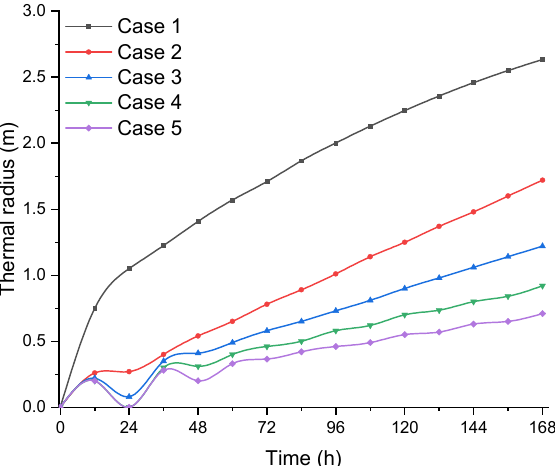
Figure 8. Variation in thermal radius with time under different precooling times.